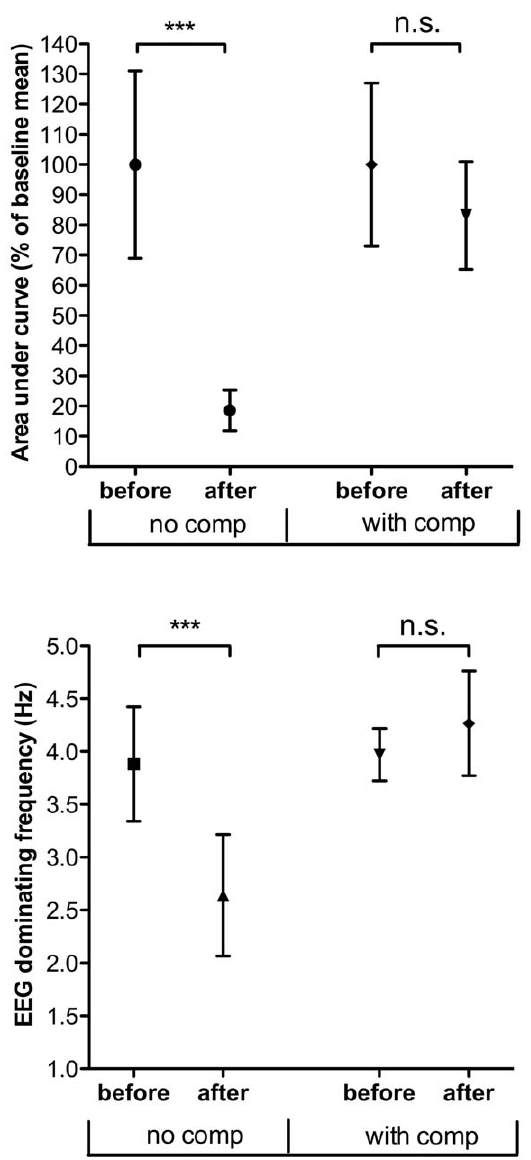
Figure 3. The effect of Midazolam on LCEP and EEG. Normalized grand mean and standard deviation of averaged LCEP area under curve and EEG dominant frequency recordings is shown. ‘‘With comp’’ represents experiments with adjustment of volatile anaesthesia to keep a stable dominant EEG frequency after drug. ‘‘before’’ represents baseline measurements before drug and ‘‘after’’ represents LCEPs elicited after drug administration. The results from student’s t-test are also shown. See methods section for details. being considered as a statistically significant difference. Statistical analysis was also performed to ascertain that the baseline dominant frequency of EEG was similar between the different experimental groups (unpaired student’s t-test with Welch’s between animal groups, all data within each group are normalized to its respective baseline measurement mean (see table 2 for data before normalization).